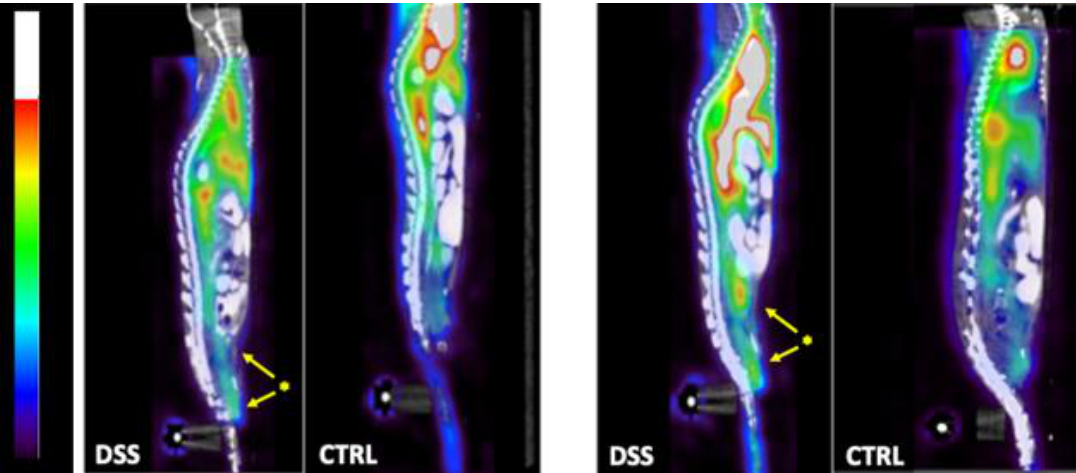
Figure 6. Representative sagittal SPECT/CT images of DSS and CTRL mice injected with 99m Tc-anti- α 4 β 7 ( left ) or 99m Tc-anti-TNF α ( right ). * = large bowel activity.